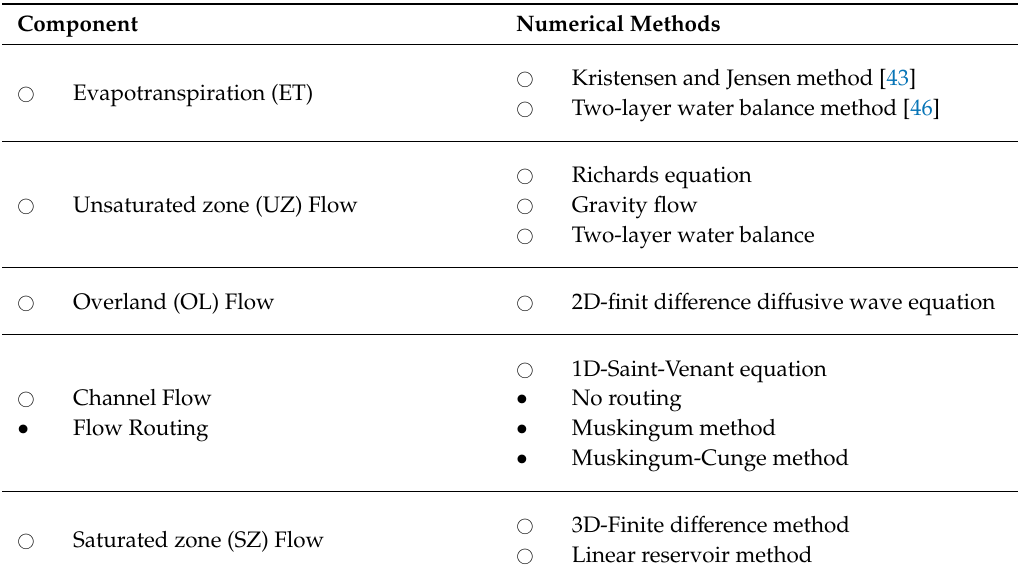
Table 3. MIKE SHE water modelling components and related numerical solutions